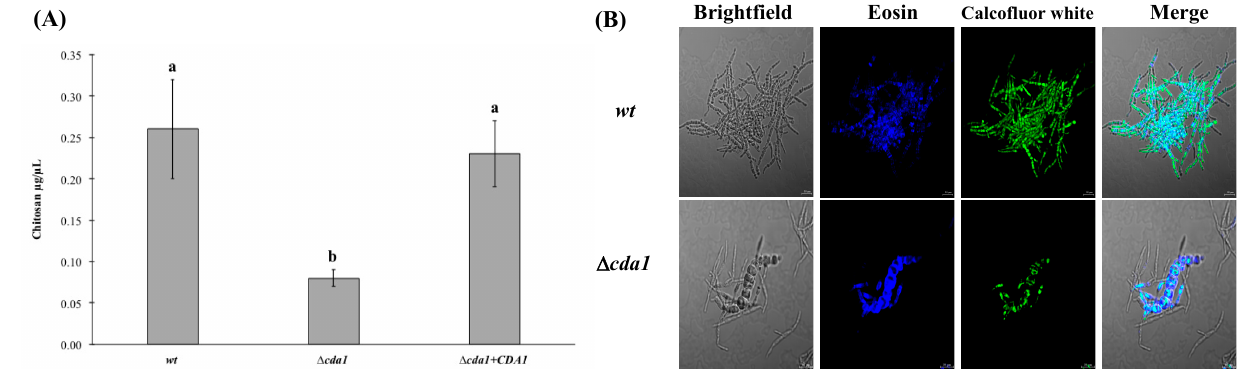
Figure 3. Determination of chitosan in the cell wall. ( A ) Chitosan quantification in a2b2 wild type, ∆ cda1 , and ∆ cda1 + CDA1 strains. ( B ) Cell morphology of U. maydis a2b2 wt and ∆ cda1 strains grown in pH 3 minimal medium. Cells were observed under brightfield, fluorescence with calcofluor white or eosin, and the merge. Results from four independent experiments with two replicas in each one. Bars represent standard error values. Different letters denote significant differences (ANOVA and Tukey’s test were performed, and reliability was 95%).